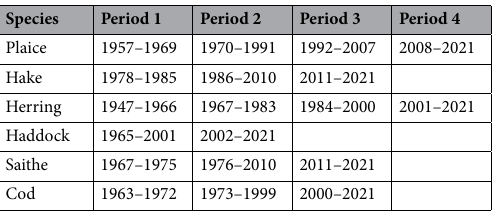
Table 1. Abrupt changes in North Sea fish stocks. Periods of quasi-stability in spawning stock biomass (SSB) identified by statistical change point